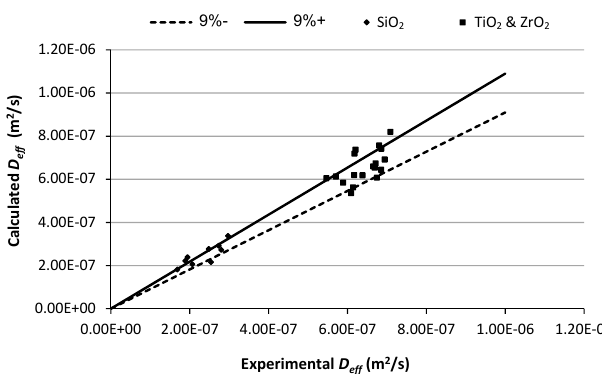
Fig. 8. Comparison of experimental and calculated D eff